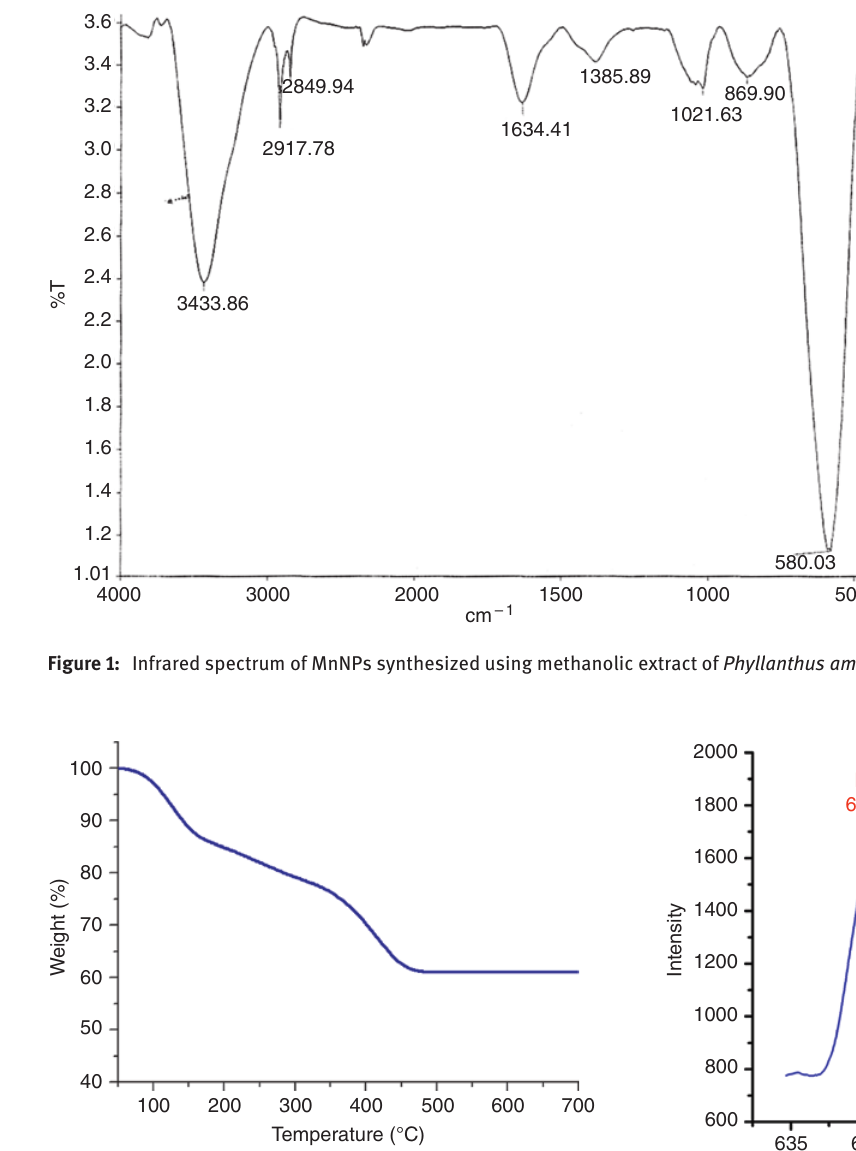
Figure 2: TGA diagram of as-prepared MnO